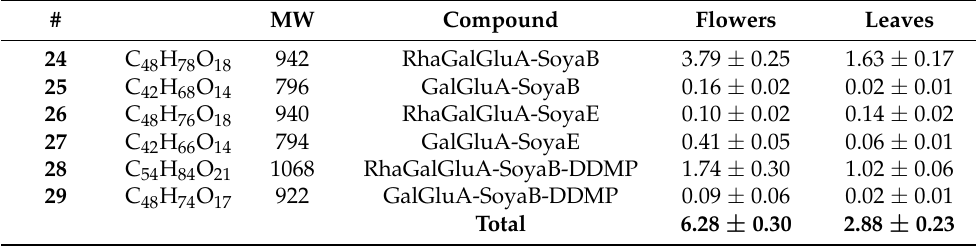
Table 2. Saponin content (mg/g DM) in flowers and leaves of H. coronarium